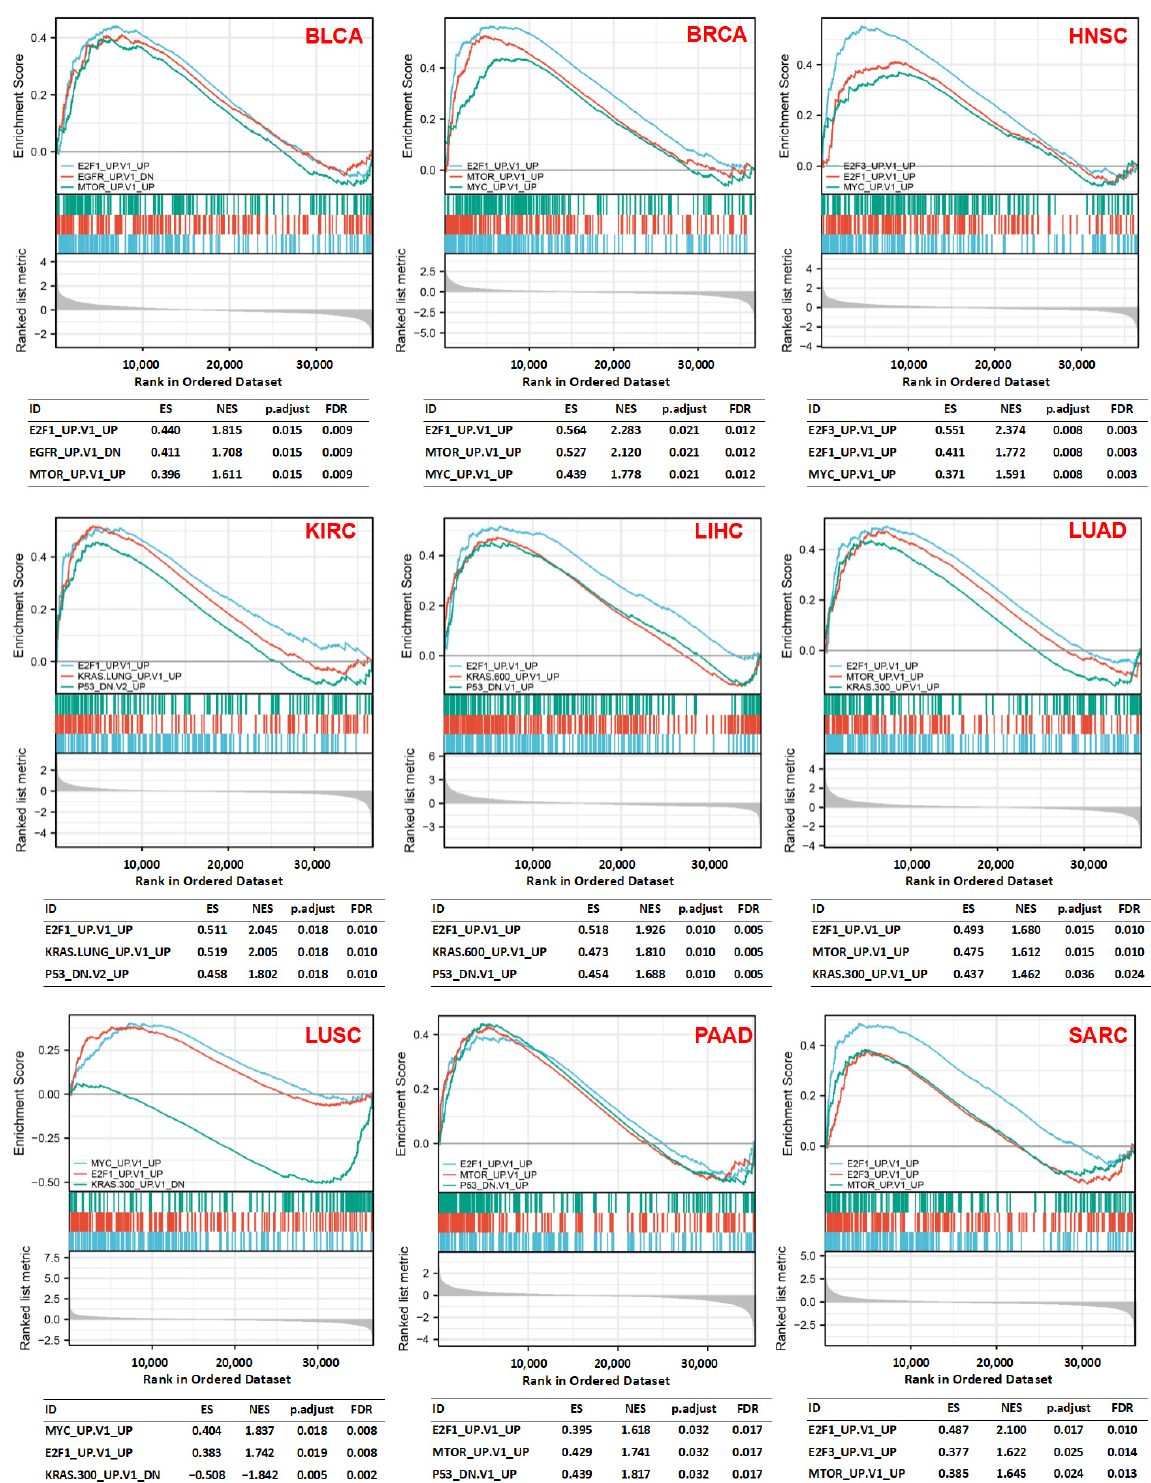
expression on the far left, while downregulated genes are shown on the right. NES: normalized enrichment score; FDR: false discovery rate.